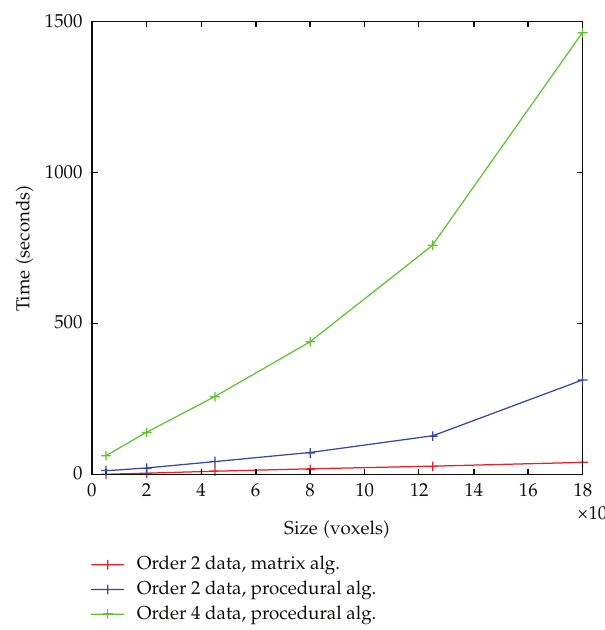
Figure 8: Run time of Helmholtz decomposition for tensor fields of various orders and